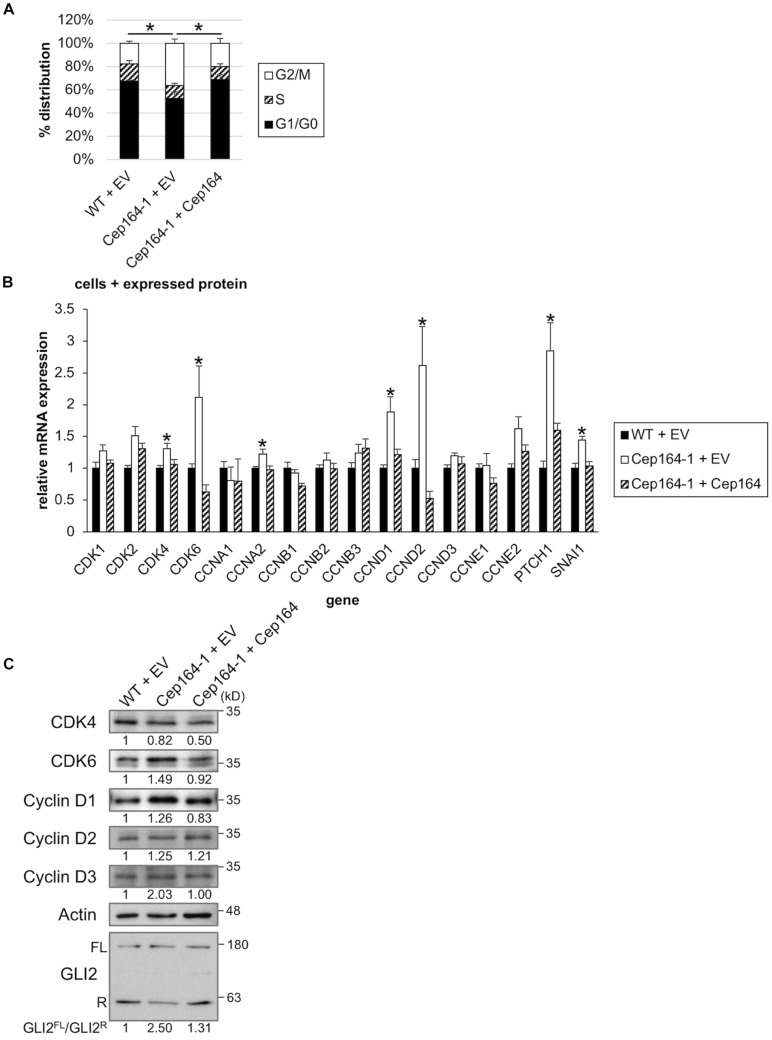
CEP164 depletion accelerates the cell cycle by elevation of Cyclin D-CDK6. (A) The indicated Panc1 cells were cultured in serum-fed medium for 48 h and analyzed using FACS. The proportion of cells at each cell cycle stage was determined. The average of three independent experiments is shown. (B,C) The indicated Panc1 cells were cultured in serum-fed medium for 48 h. (B) Relative amounts of the indicated mRNA were determined using quantitative PCR. GAPDH was used as a control. The average of four to eight independent experiments is shown. (C) Cell extracts were immunoblotted with indicated antibodies. β-Actin was used as a loading control. The amount of indicated proteins was quantified using ImageJ, and the relative values and GLI2FL/GLI2R ratio are shown below the image. (A,B) All data are shown as mean ± SEM. *p < 0.05 compared with Cep164-1 + EV (A) (Chi-squared test), compared with WT + EV and Cep164-1 + Cep164 (B) (two-tailed Student’s t-test). Uncropped images of western blots are shown in Supplementary Figure 5.